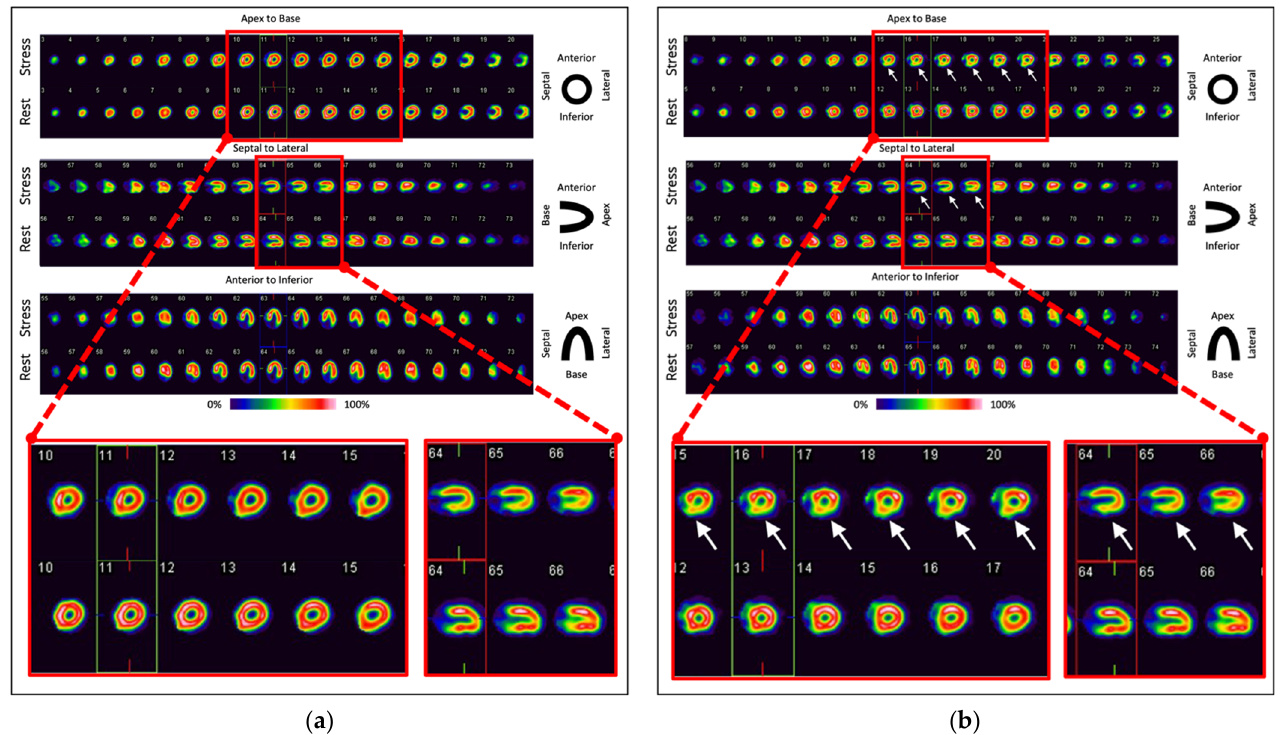
Figure 4. ( a ) Example for a physiological result in myocardial perfusion SPECT: No stress-induced perfusion defects, no ischemia, normal LVEF in stress and rest conditions ( ≥ 55%). ( b ) Example for a pathologic result: Stress-induced perfusion defects of the posterior wall (white arrows, ischemia: 10% of left-ventricular myocardium), normal LVEF in stress and rest conditions ( ≥ 55%). Images were acquired at our institution.